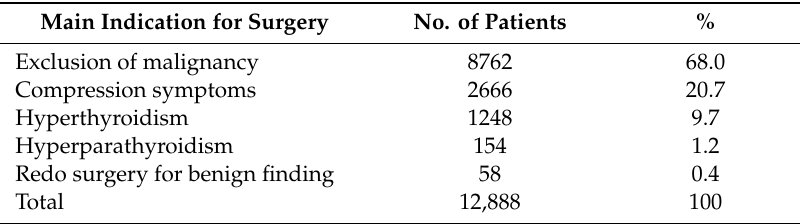
Table 2. Main indication for thyroid surgery in histologically benign lesions. Main Indication for Surgery